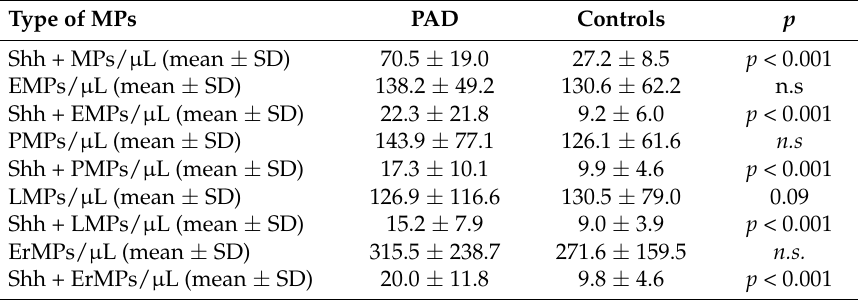
Table 2. Number and type of circulating MPs in PAD patients and controls.